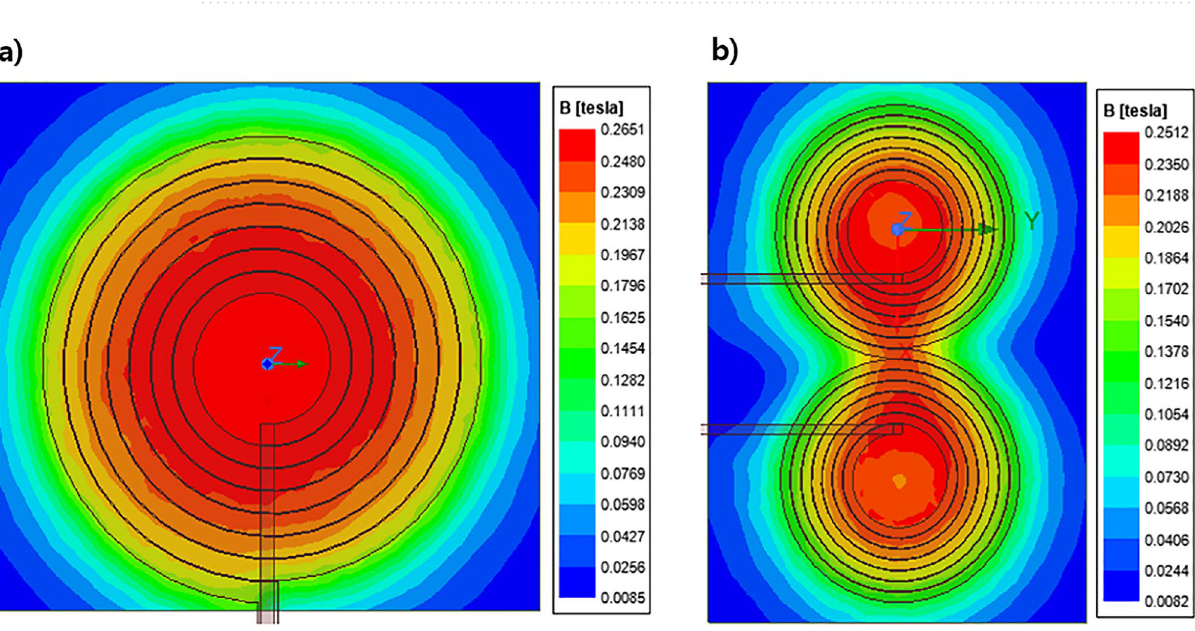
Figure 4. Simulation setup of coils for simulation of magnetic field intensity: ( a ) designed circular coil; ( b ) figure 8-shaped coil.